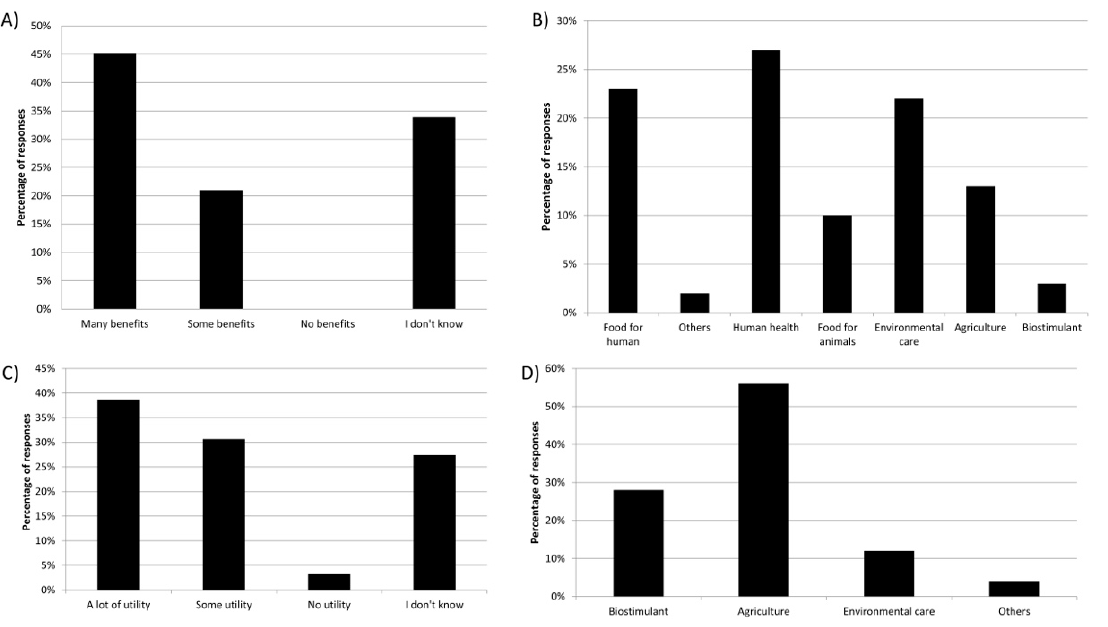
Figure 2. ( A ) Variety of benefits provided by microalgae for society. ( B ) Beneficial uses of microalgae for society. ( C ) Level of the utility of microalgae in agriculture. ( D ) Diversity of applications of microalgae in agriculture.